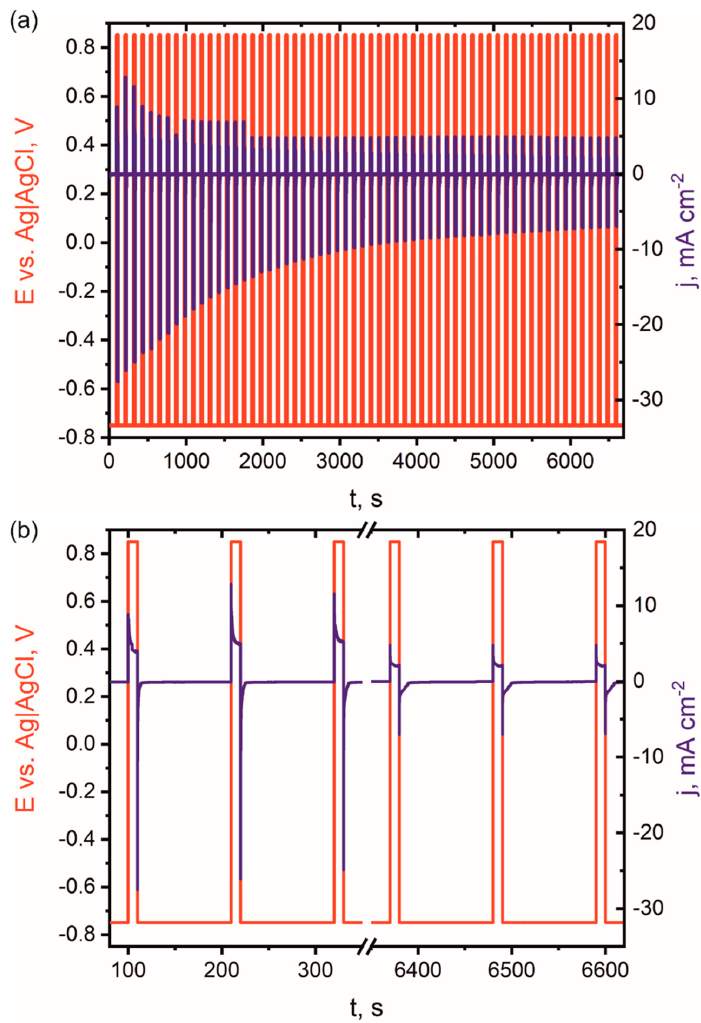
Figure 2. Time profiles of the applied potential and resulting current density for the whole electrodeposition ( a ) and 3 first and last pulses ( b ). electrodeposition ( a ) and 3 first and last pulses ( b